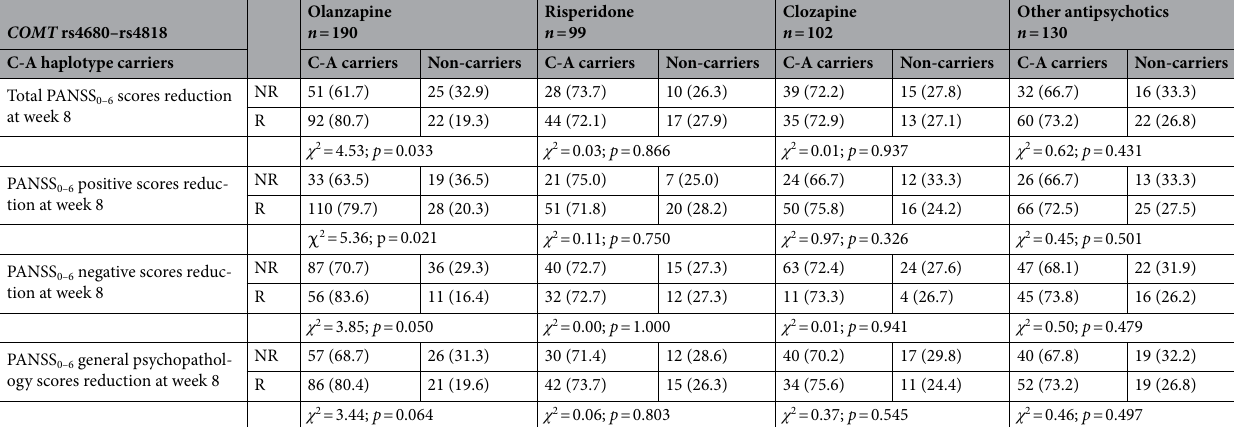
Table 7. Haplotype frequencies of COMT rs4680 and rs4818 polymorphisms in schizophrenia patients treated with olanzapine, risperidone, clozapine or other antipsychotics, subdivided into responders (R) and non- responders (NR) according to the 50% reduction in PANSS 0–6 total and subscale scores. Frequencies (%) are shown in parenthesis. n number of subjects, NR non-responders, PANSS positive and negative syndrome scale, R responders.